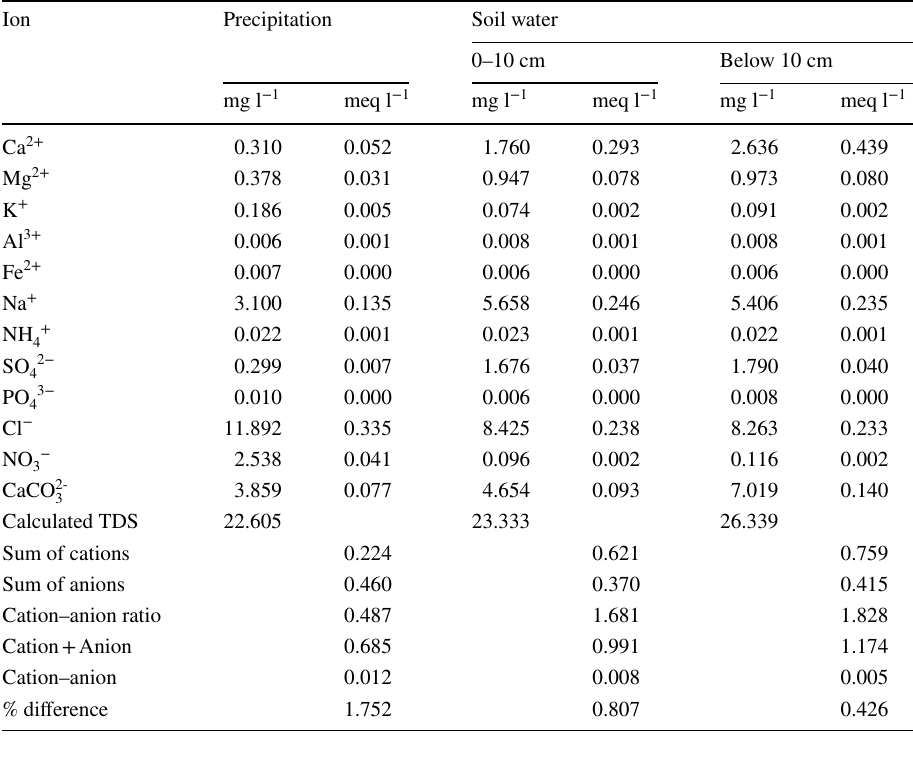
Table 2 Ion balance estimates of precipitation and soil water chemistry